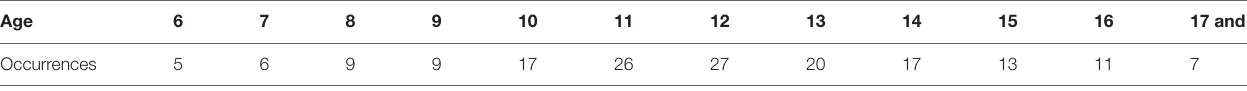
TABLE 1 | Distribution of occurrences of ages in the corpus.